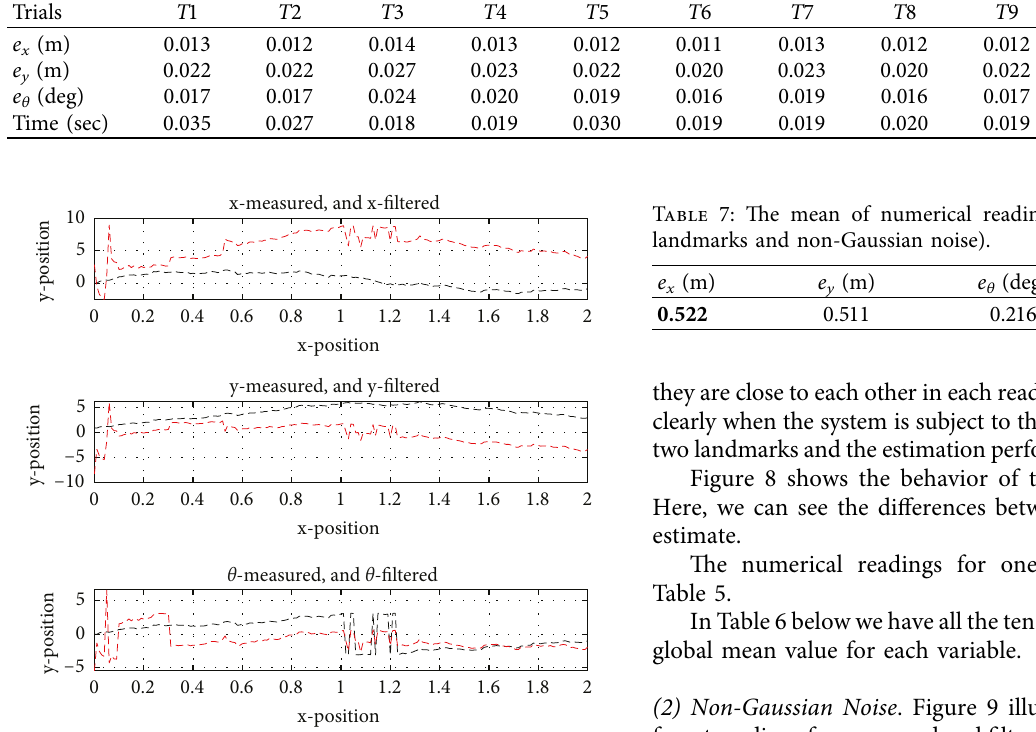
Figure 9: EKF performance with two landmarks and non-Gaussian noise.